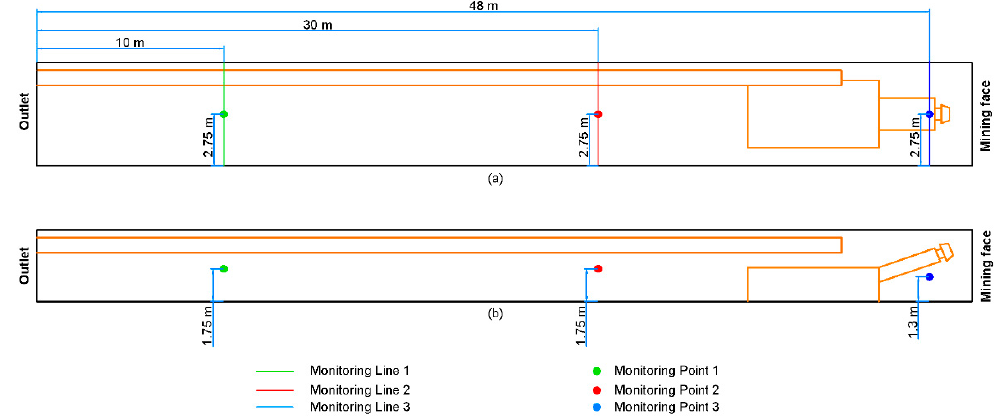
Figure 2. Position of monitoring lines and points.